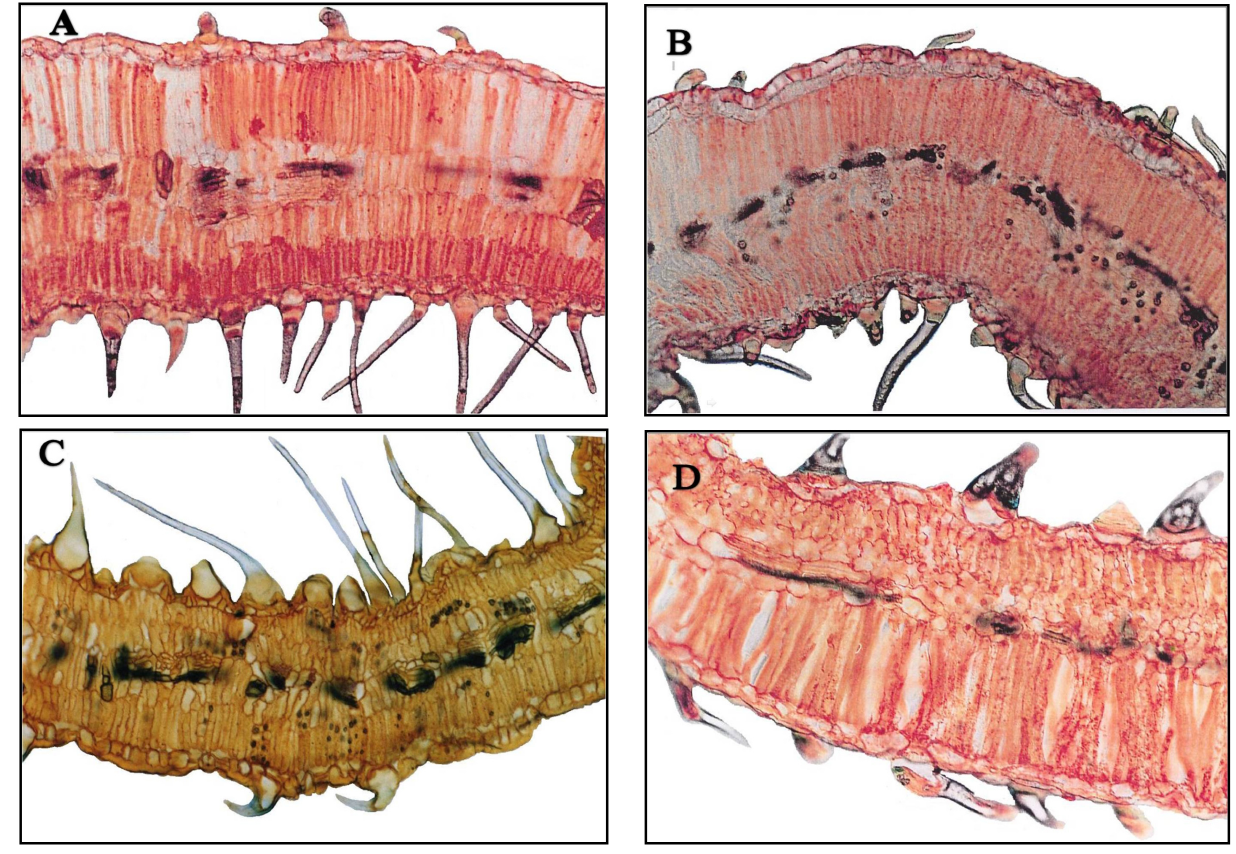
Fig. 5. Lamina of Heliotropium species in T.S; H. transoxanum (A); H. dasycaypum (B); H. digynum (C); H. ellipticum